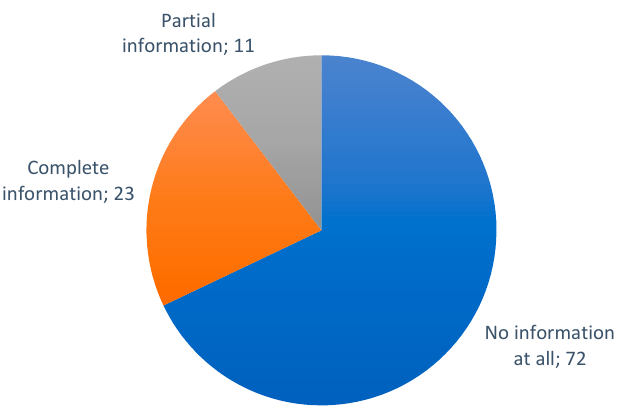
Figure 12. Information about the used moisture sensors in all the evaluated papers.